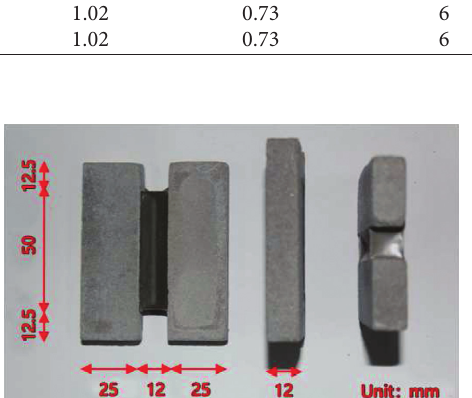
Figure 2: Sizes of